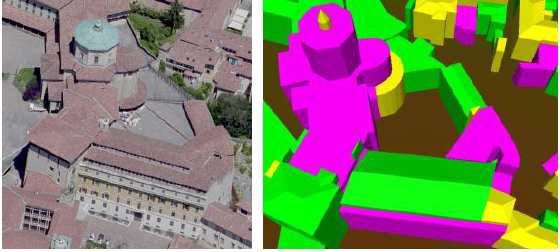
Figure 9. Example of building roofs not correctly modelled by “CityModeller” due to unusual and complex roof shapes. Although the user can define its own primitives, we found it more convenient to manually edit the “partially”